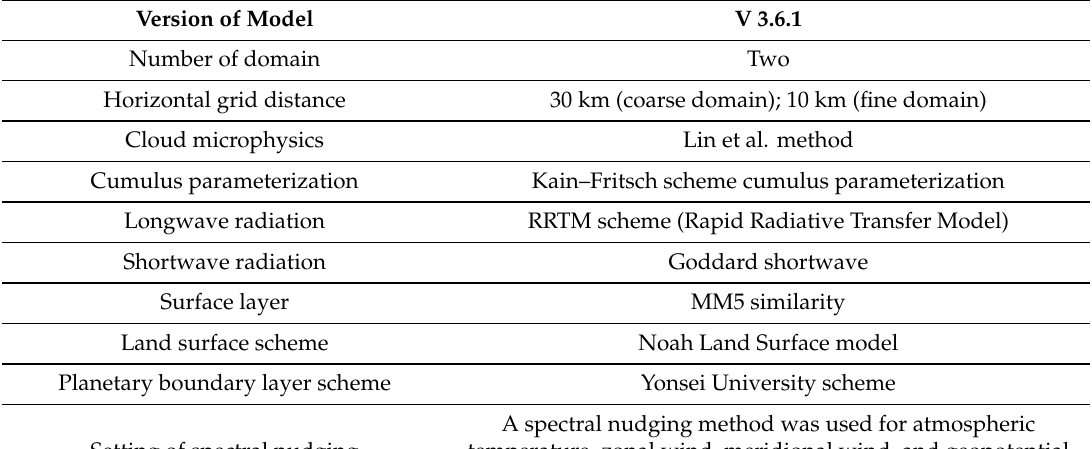
Table 3. Settings in the Weather Research and Forecasting